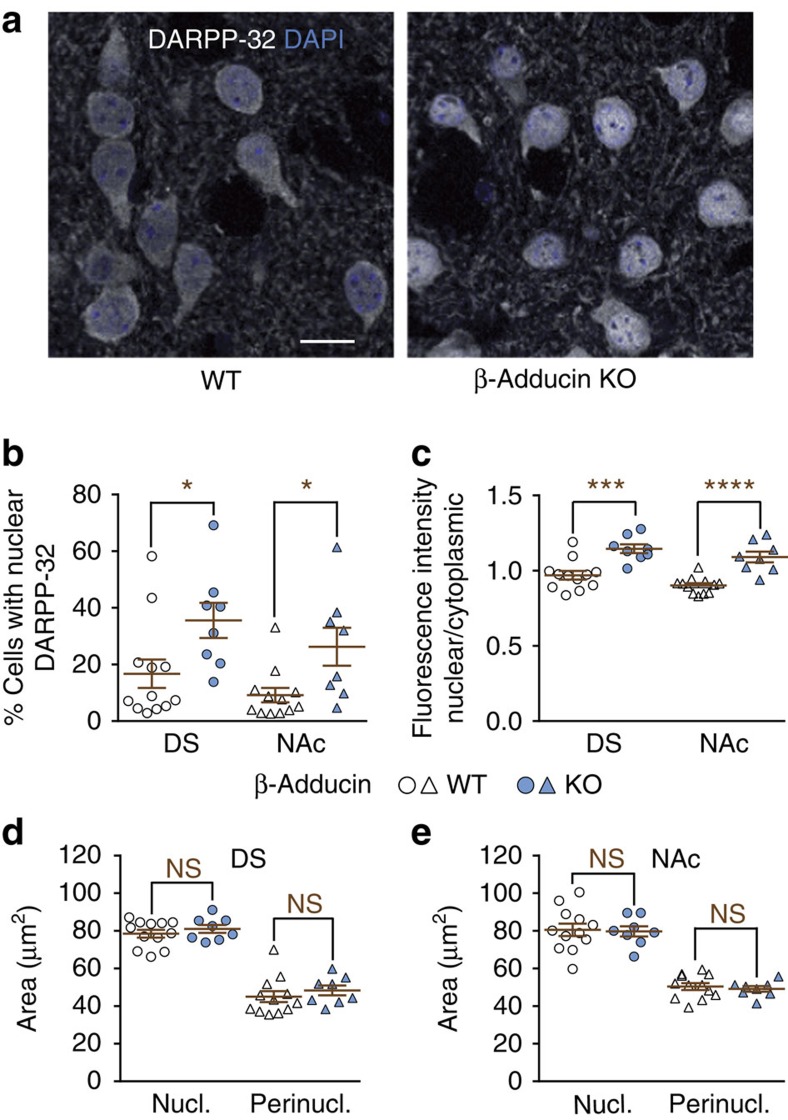
β-adducin influences DARPP-32 cytonuclear localization in vivo.(a) Dorsal striatum sections from WT or β-adducin KO mice were labelled with DARPP-32 antibody and nuclei were stained with DAPI. Scale bars, 10 μm. (b) The percentage of cells with DARPP-32 immunoreactivity intensity in the nucleus greater than or equal to the cytoplasm was quantified in the dorsal striatum (DS) or nucleus accumbens (NAc) of β-adducin KO mice and WT littermates in sections as in a. Independent data points are plotted and means±s.e.m. are shown, n=8–12 mice per group from 2 experiments; two-way ANOVA: region effect, F(1,36)=2.7, not significant (NS); genotype effect, F(1,36)=12.6, P<0.001; no interaction, F(1,36)=0.03; post hoc multiple comparison Šidák's test, β-adducin KO versus WT, *P<0.05. (c) Same as in b except that the fluorescence intensity ratio between nucleus and cytoplasm was quantified. Two-way ANOVA: region effect, F(1,36)=4.98, P=0.03; genotype effect, F(1,36)=44.7, P<10−4; no interaction, F(1,36)=0.052; Šidák's test, β-adducin KO versus WT, ***P<0.001, ****P<10−4. The nucleus (Nucl.) and perinuclear cytoplasm (Perinucl.) areas were measured in the DS (d) and NAc (e). No significant difference between genotypes was detected: two-way ANOVA: genotype effect, DS, F(1,36)=1.24, P=0.30; NAc, F(1,36)=0.16, P=0.69.